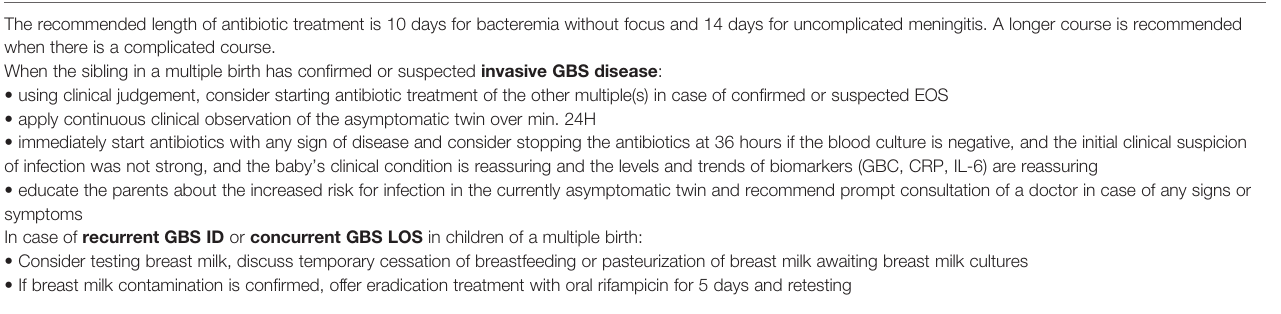
TABLE 5 | Practical recommendations for investigations and management of the asymptomatic twin in case of invasive GBS disease in a multiple birth or with recurrent course. The recommended length of antibiotic treatment is 10 days for bacteremia without focus and 14 days for uncomplicated meningitis. A longer course is recommended when there is a complicated